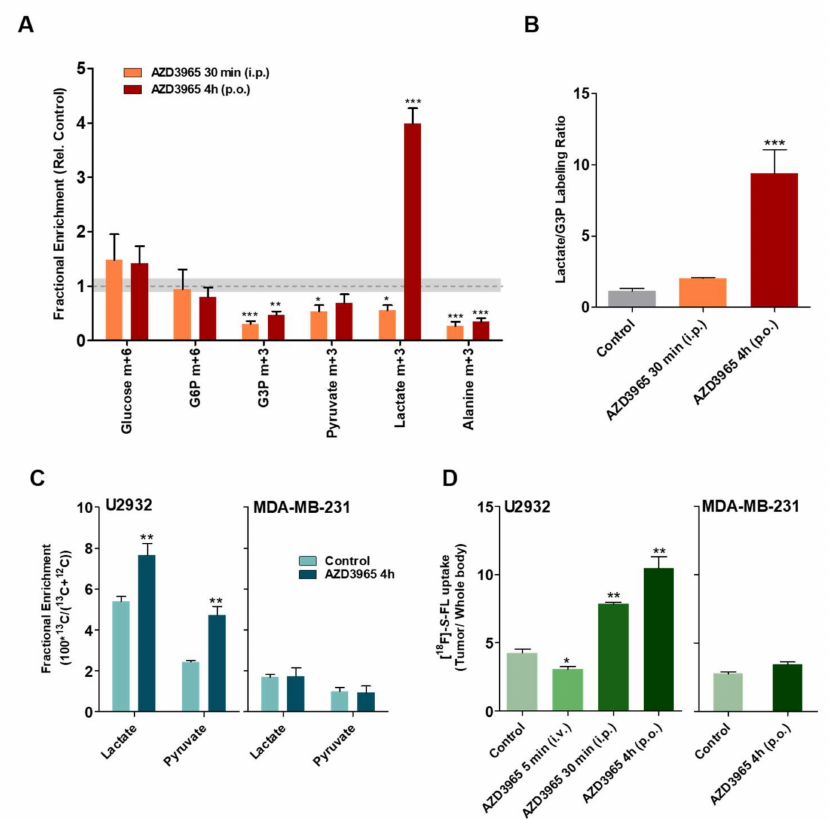
Figure 4. AZD3965-mediated inhibition of lactate import is reversed in DLBCL tumors. ( A ) Tissue enrichment of glucose m + 6, glucose 6-phosphate (G6P) m + 6, glyceraldehyde-3-phosphate (G3P) m + 3, pyruvate m + 3, lactate m + 3 and alanine m + 3 in U2932-bearing mice infused with D-[ 13 C 6 ]glucose following treatment with AZD3965 (100 mg / kg) for 30 min (i.p.) or 4 h (p.o.). Data are expressed as fractional enrichment relative to control (vehicle), indicated by the dotted line (average) and shaded bar (SEM). ( B ) Lactate to glyceraldehyde-3-phosphate (G3P) labeling ratios of tumors from (A). ( C ) Fractional enrichment of lactate and pyruvate in U2932 (left) and MDA-MB-231(right)-tumor bearing mice infused with L-[1- 13 C]lactate following treatment with AZD3965 (100 mg / kg) for 4 h. ( D ) Radioactive uptake of [ 18 F]- S -FL after treatment with 100 mg / kg of AZD3965 for 5 min (i.v.), 30 min (i.p.) in U2932 tumors and 4 h (p.o.) in both U2932 and MDA-MB-231 tumors, normalized to whole body uptake. All data are average ± SEM ( n = 4 ). * p ≤ 0.05, ** p ≤ 0.01 and *** p ≤